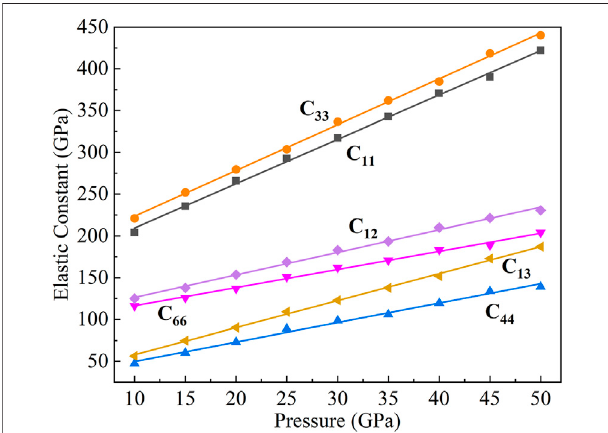
FIGURE 7 | Elastic constants of CaO 3 under 10 – 50 GPa. The black squaresrepresentC 11 ,thepurplediamondsrepresentC 12 ,theobliqueyellow triangles represent C 13, the orange circles represent C 33 , the regular blue triangles represent C 44 , and the inverted magenta triangles represent C 66 .